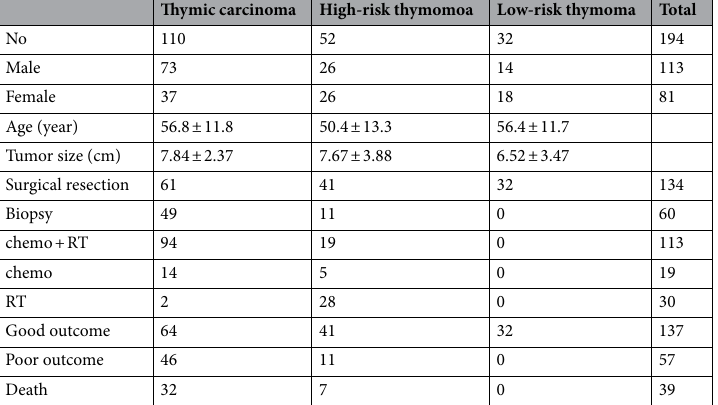
Table 1. Clinical data for 194 cases of thymic epithelial tumors. chemo chemo chemotherapy, RT radiation